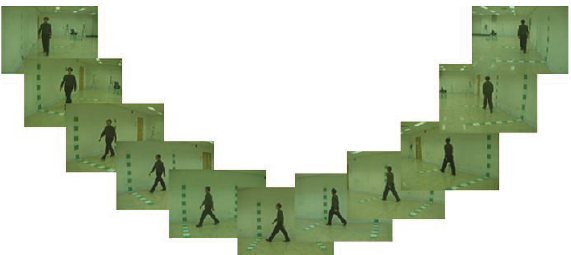
Figure 12: Human gaits captured from 11 di ff erent view angles.